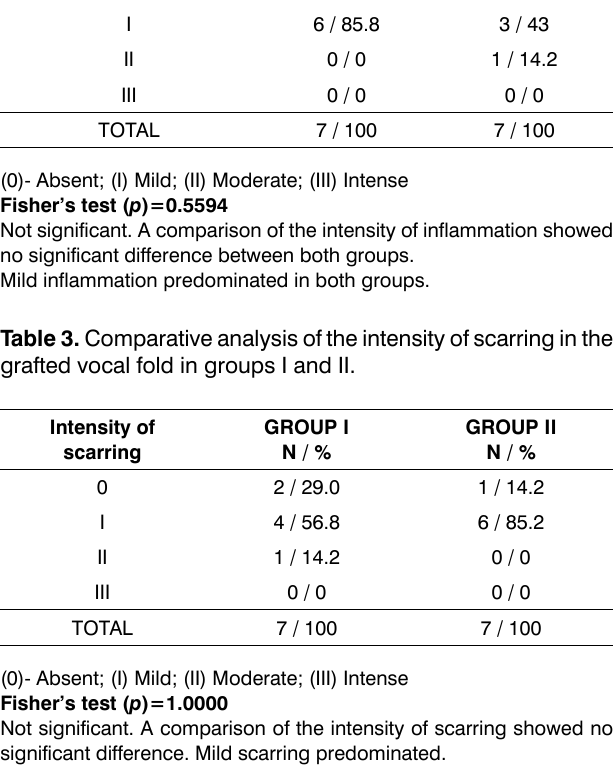
Table 4. Comparative analysis of the presence of foreign body chronic reaction among grafted vocal folds in both groups.